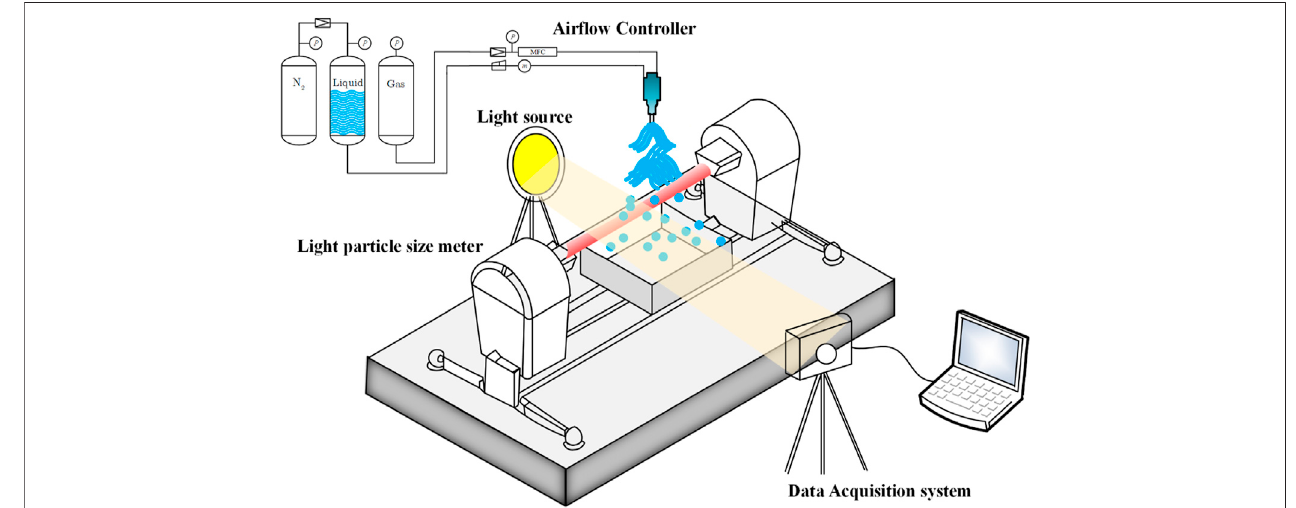
FIGURE 1 | The schematic of the present experimental atomization system.